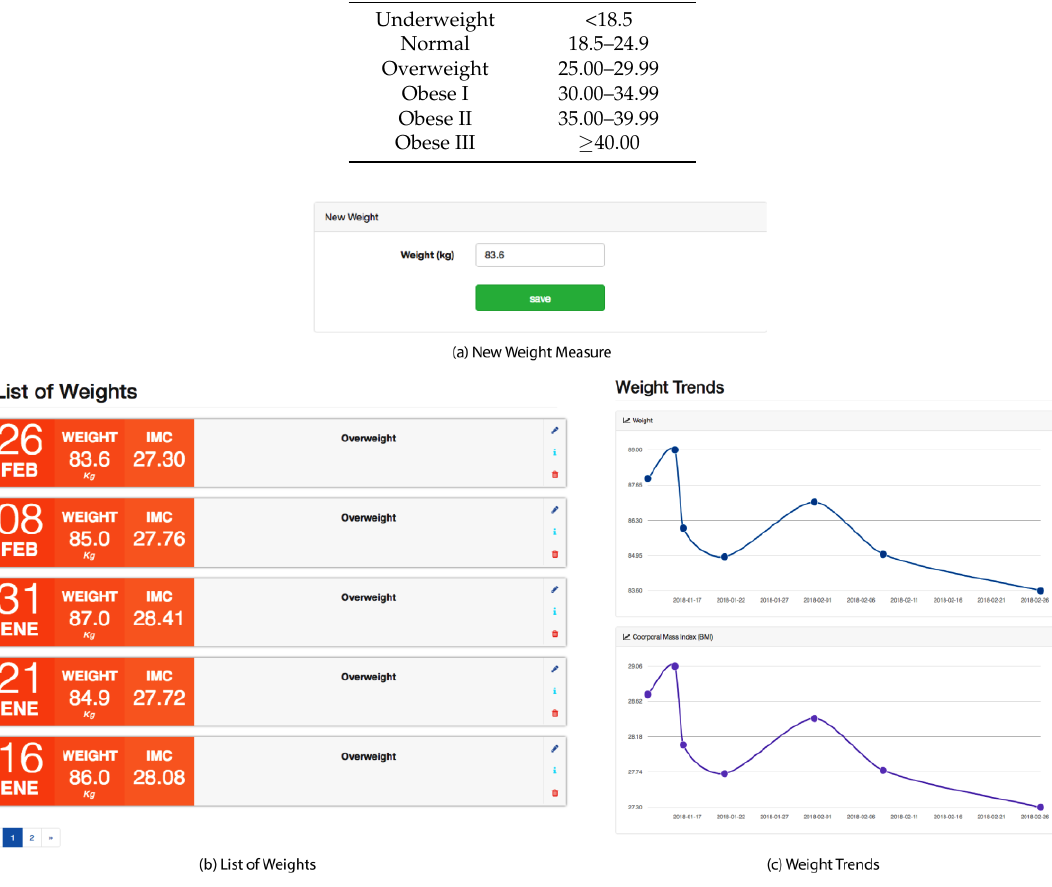
Figure 7. Weight module.